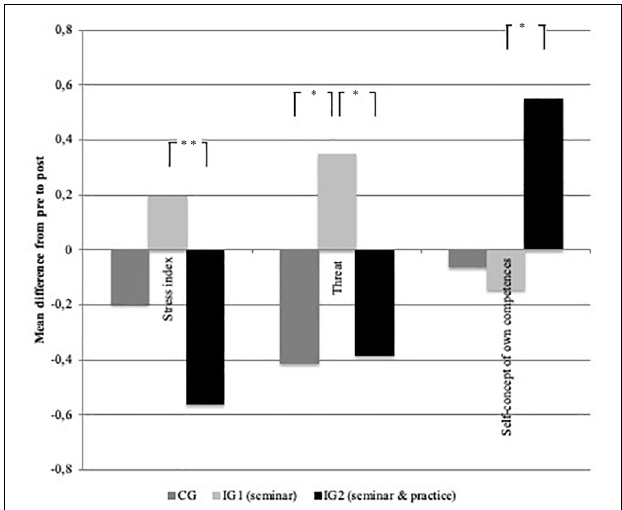
FIGURE 2 | Mean difference from pre to post for overall stress index and the subscales “threat as well as self-concept of own competencies”; * p < 0.05, ∗∗ p <